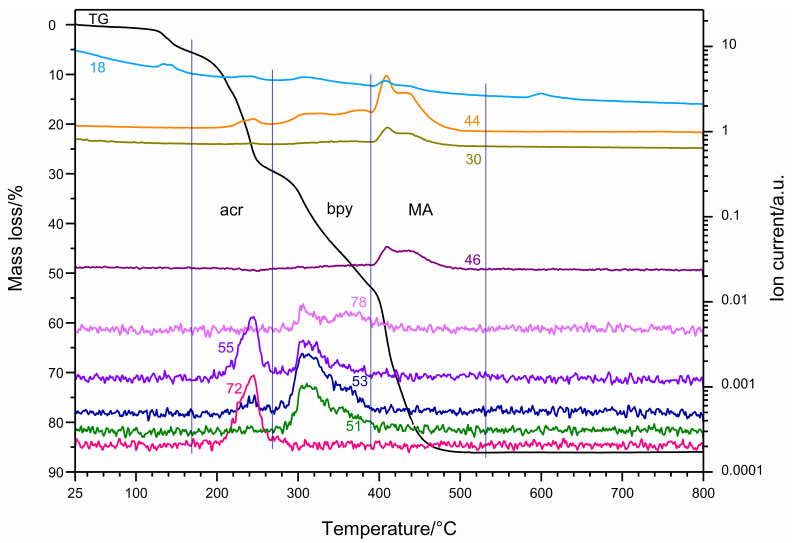
Figure 6. TG-MS curves in air of compound 1